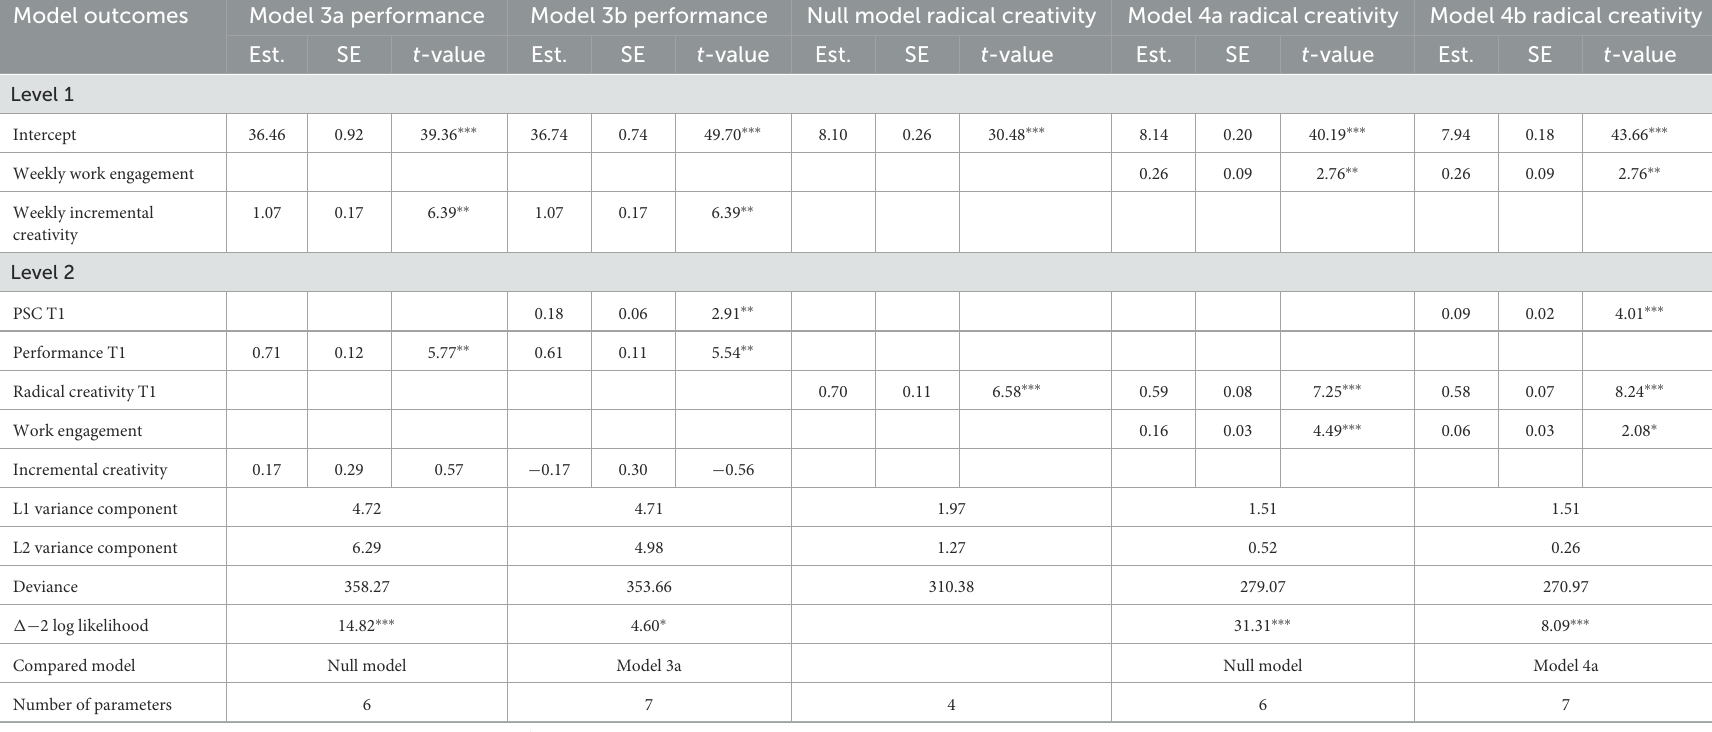
TABLE 4 HLM results of weekly radical and incremental creativity as